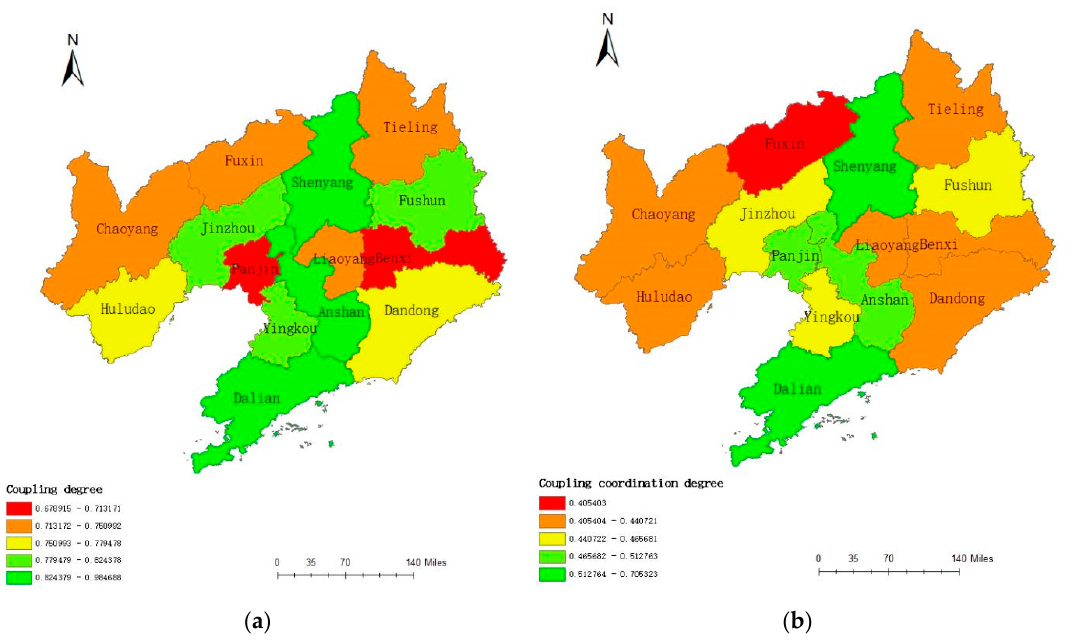
Figure 7. ( a ) Coupling degree of “three states” coordinated development of high-quality human settlements; ( b ) coupling coordination degree of “three states” coordinated development of high- quality human